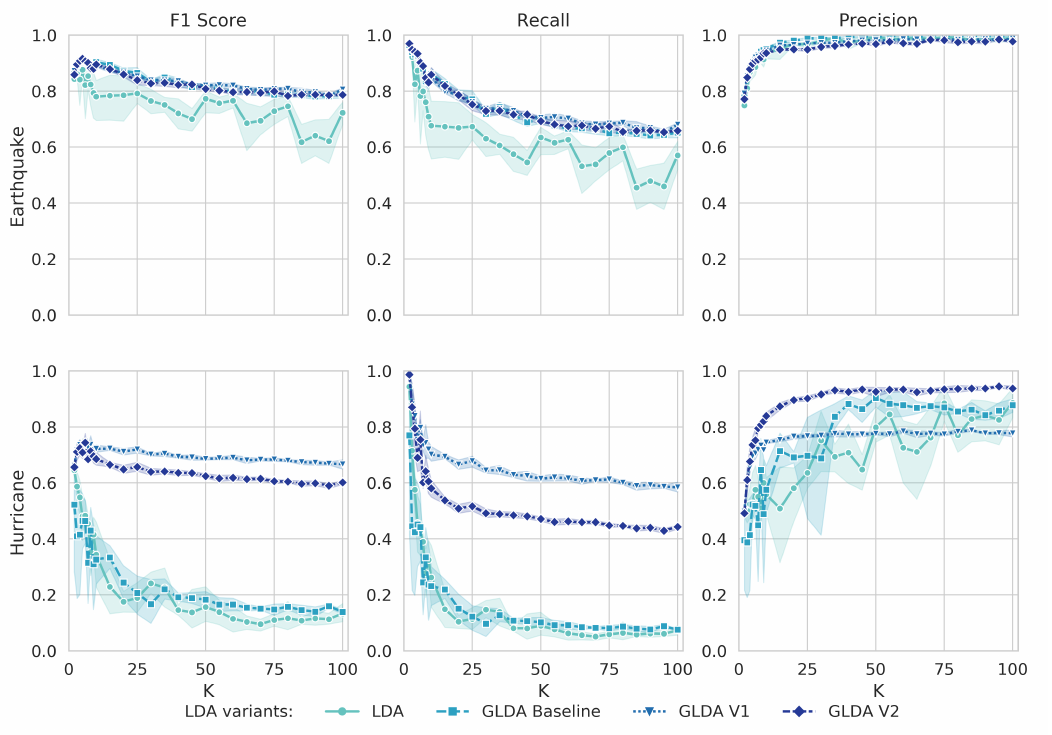
Figure 5. Results of the Tweet classification on the test set: F 1 score ( left ), recall ( middle ) and precision ( right ) for all four model variants and varying numbers of topics K . Markers indicate the mean over five runs with same K , while the upper and lower limits refer to the 95% confidence